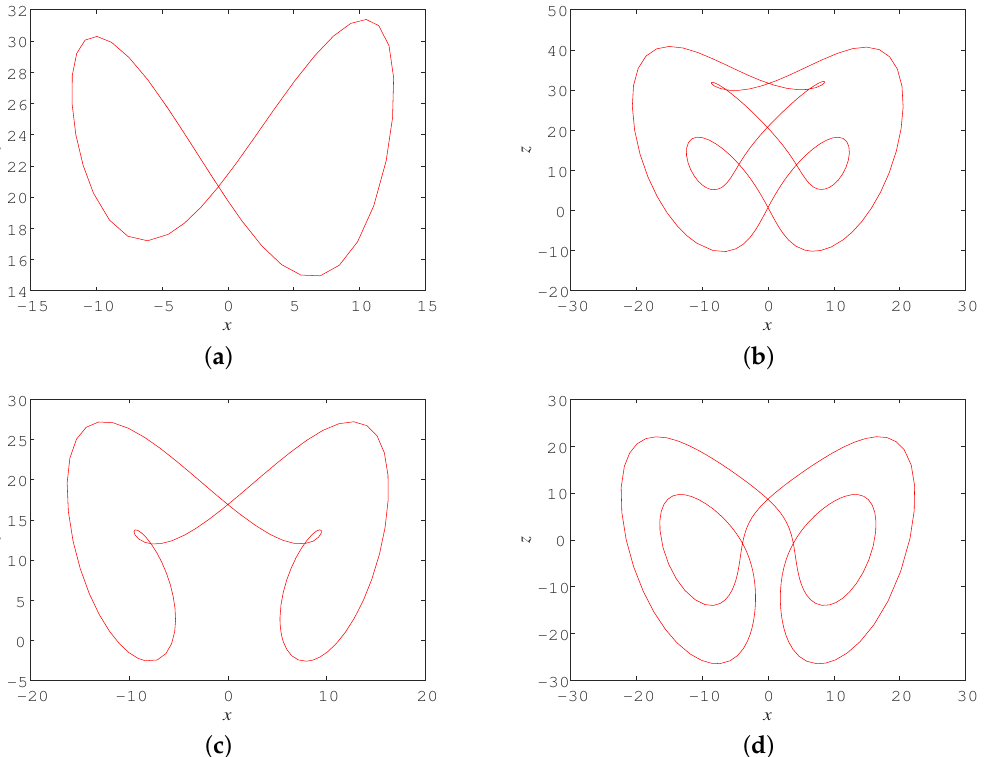
Figure 10. 2D view of different limit cycles of system (1), a = 10, b = 100, k = − 0.2: ( a ) c = − 12; ( b ) c = − 7.74; ( c ) c = − 7.2; and ( d ) c =